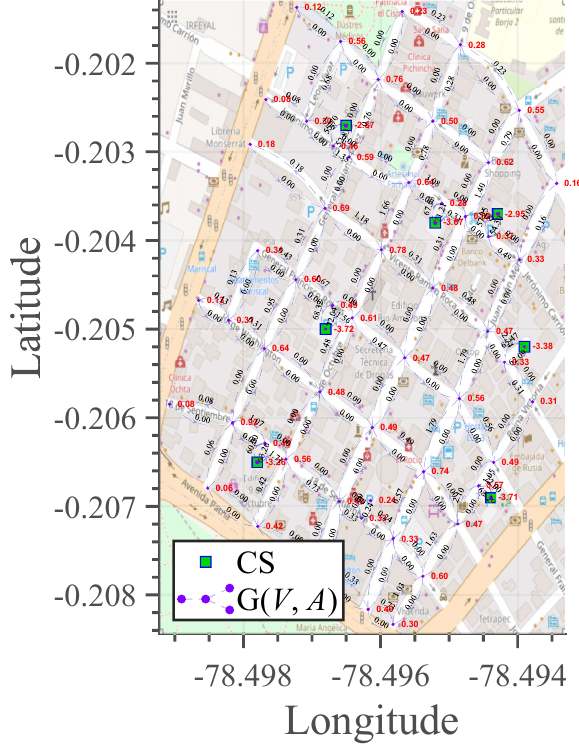
Figure 6. Optimal overall solution for battery charging in electric